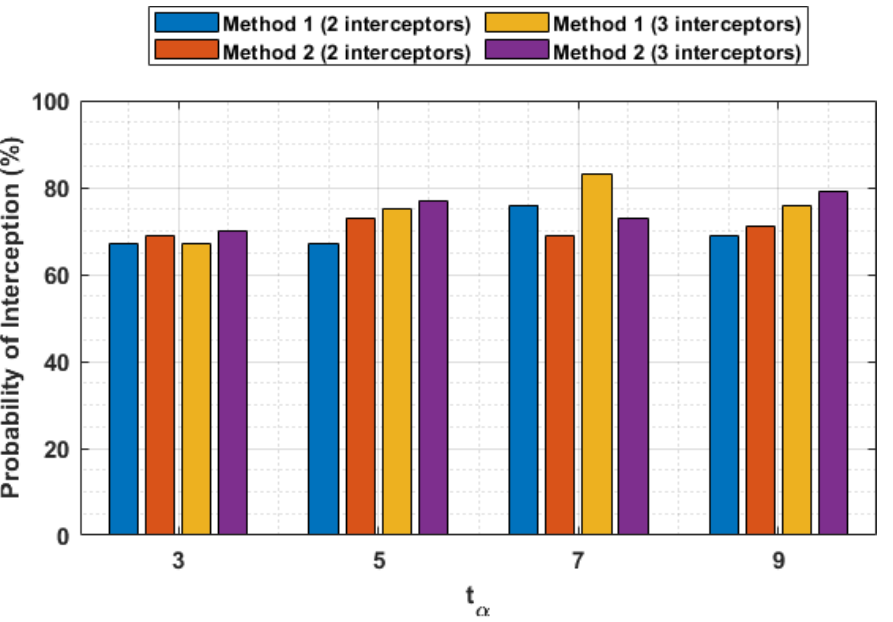
Figure 13. Comparison of probability of interception for all t α , in Case